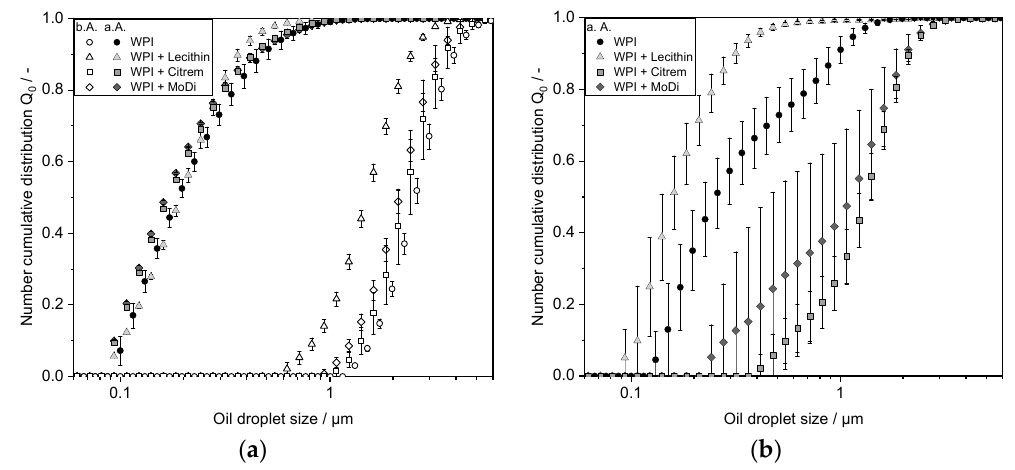
Figure 3. Number of cumulative distributions of oil droplet size of emulsions stabilized with (WPI) and WPI/LMWE (b. A.) and after (a. A.) atomization. ( a ) Oil content: 1 wt.%; ( b ) Oil content: 30 wt.%.